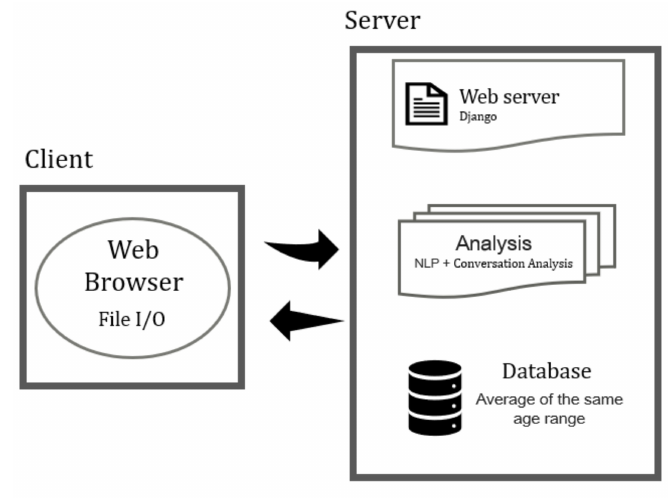
Figure 1. Configuration of the whole